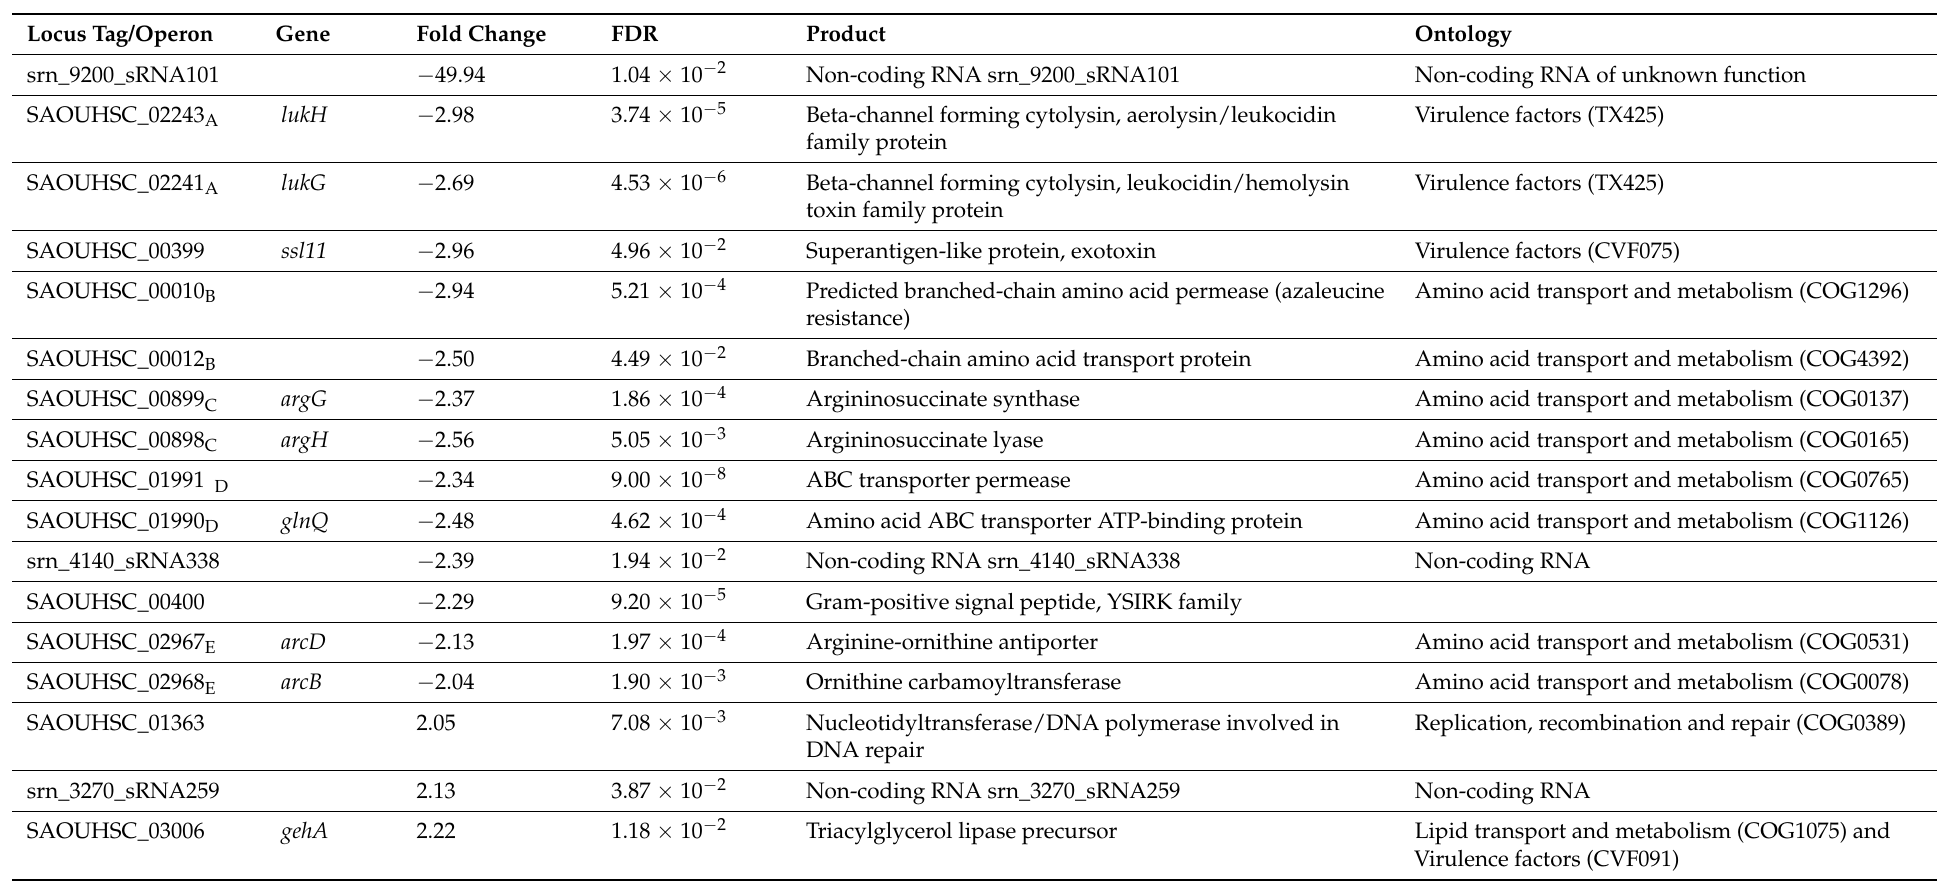
Table 1. Transcripts differentially expressed in RN4220 ∆ saoC mutant in the logarithmic growth phase. Transcripts, where applicable, are grouped into operons (capital letters in subscripts of locus tags) with the genomic order preserved, and then sorted in respect to the fold change value. In the case of operons, locus with the largest absolute fold change was taken into account whilst sorting. Negative values indicate fold-decrease in transcription. FDR, false discovery rate ( p value adjusted with Benjamini and Hochberg method). Ontologies are determined based on the transcript type (non-coding RNA), COG database (COG IDs given in parentheses), Virulence Factor Database (VFDBIDs given in parentheses) or available literature